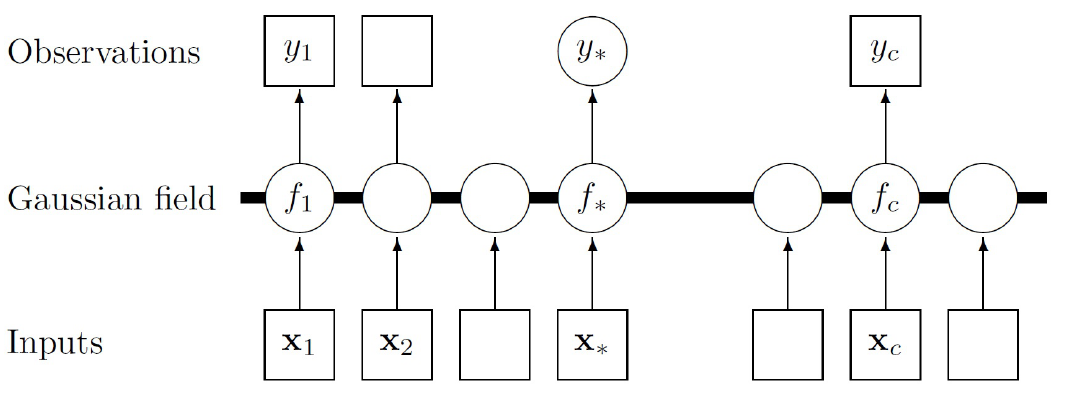
Figure 1. Schematic illustration of Gaussian process regression [19]. x 1 to x c and y 1 to y c form the training set, while ( x ∗ , y ∗ ) forms the test set. The Gaussian field represents the Gaussian distribution over